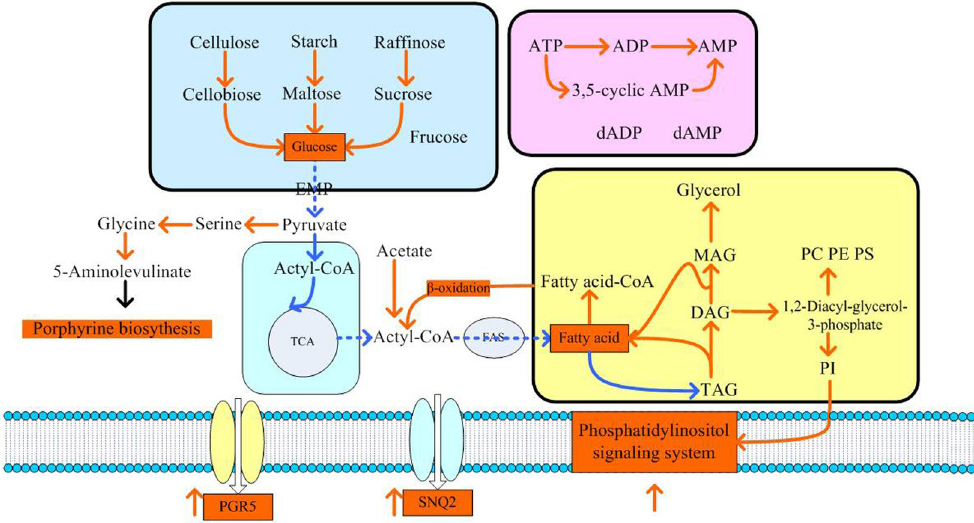
Figure 4. Cell response to the environment of carbon starvation during lipid turnover stage. Yellow: up-regulated; Blue: down-regulated. Abbreviations for genes: MAG: monoacylglycerol; DAG: 1,2-Diacyl-sn-glycerol; TAG: Triacylglycerol; PI: Phosphatidylinositol; PC: phosphatidyl choline; PE: Phosphatidylethanolamine; PS: